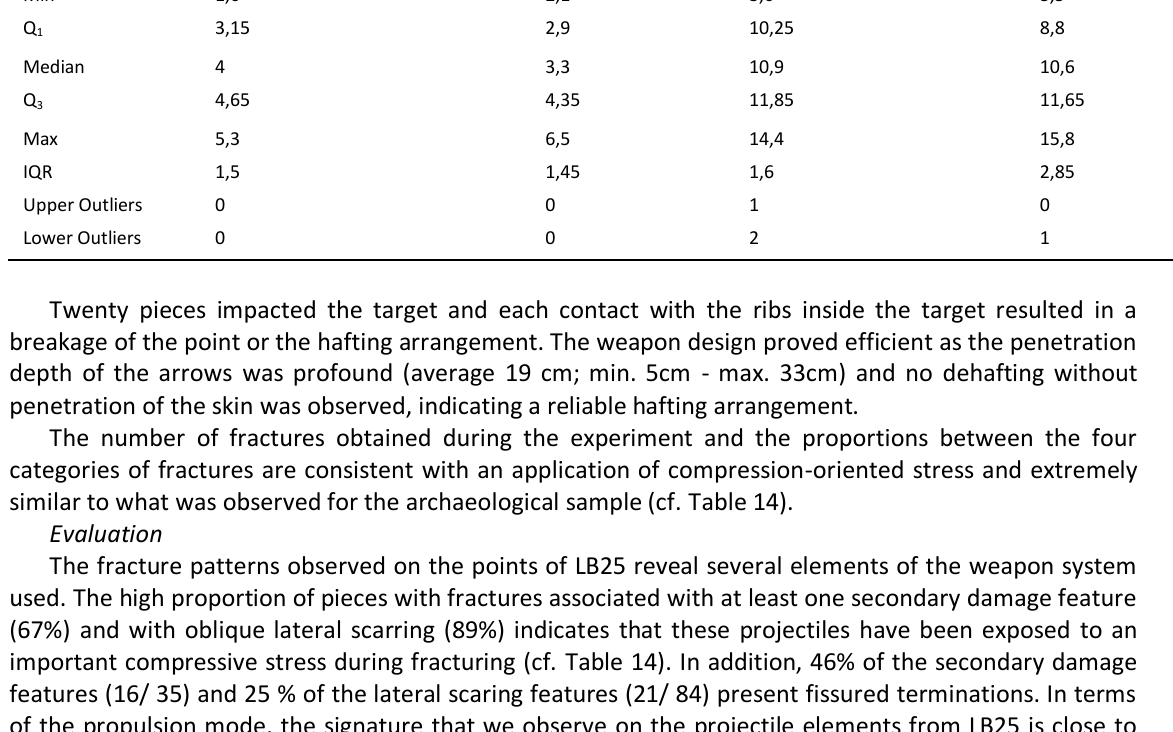
Table 13 . Summary of the morphometrical variation between the identified projectile points from Lommel-Maatheide LB25 and the experimental reproductions Maximal thickness Lommel- Maatheide